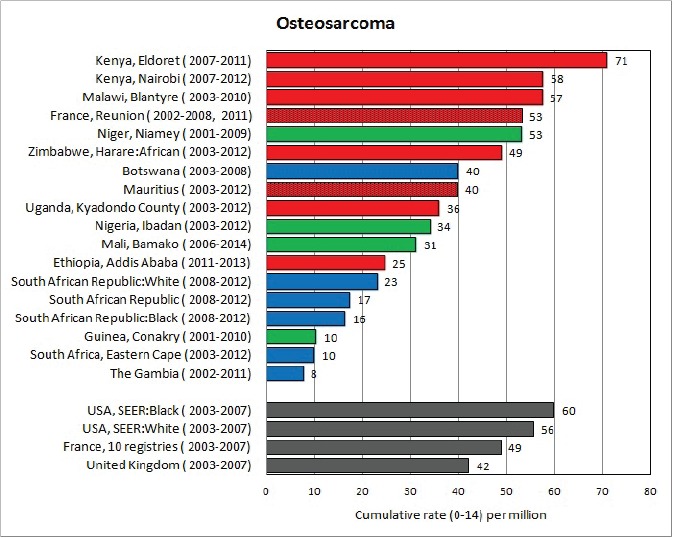
Cumulative (0–14) incidence rate—osteosarcoma.